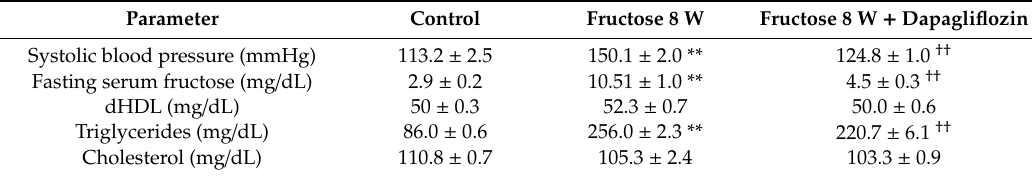
Table 2. General Characteristics of the Three Experimental Rats